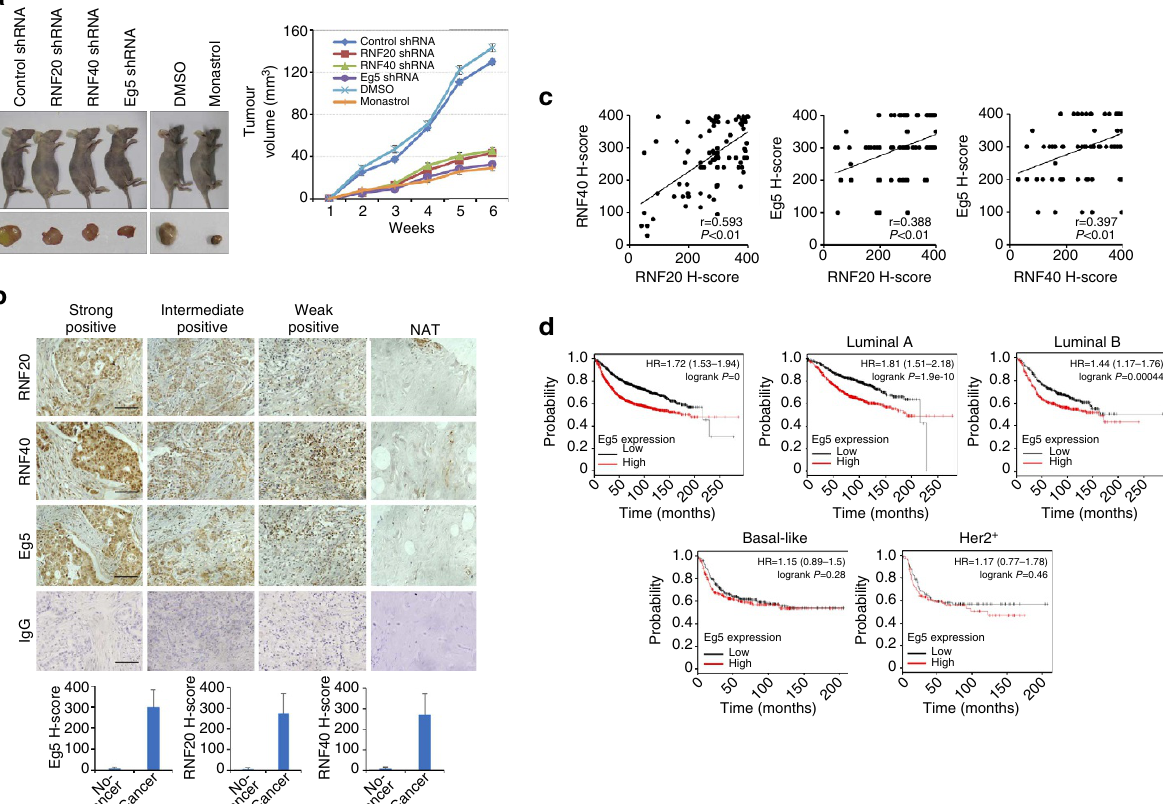
Figure 7 | RNF20/40-Eg5 axis in breast carcinogenesis. ( a ) Depletion of Eg5, RNF20/40 and Eg5 inhibition suppressed breast carcinogenesis. MCF-7 cells infected by lentiviruses carrying empty vectors or MCF-7 cells with lentivirus-delivered Eg5, RNF20 or RNF40 knockdown, were transplanted into female athymic nude mice ( n ¼ 6). Another two groups of mice with tumour xenografts developed from normal MCF-7 cells were mock treated or treated with monastrol via intraperitoneal injection. Tumours were measured weekly using a vernier calliper and the volume was calculated according to the formula: V ¼ p /6 (cid:3) length (cid:3) width 2 . Each bar represents the mean ± s.d. for six animal measurements. ( b ) Immunohistochemical staining of Eg5, RNF20 and RNF40 in breast cancer tissue microarrays. Normal IgG was used as a negative control. Scale bar, 100 m m. The expression of Eg5, RNF20 and RNF40 ( H score) in 99 breast carcinoma tissues and 10 normal breast tissues was statistically analysed. ( c ) Correlation plot of the expression of Eg5, RNF20 and RNF40 in 99 breast carcinoma tissues. Pearson’s correlation analysis was performed, and P o 0.01 was defined as statistically significant. ( d ) Kaplan–Meier overall